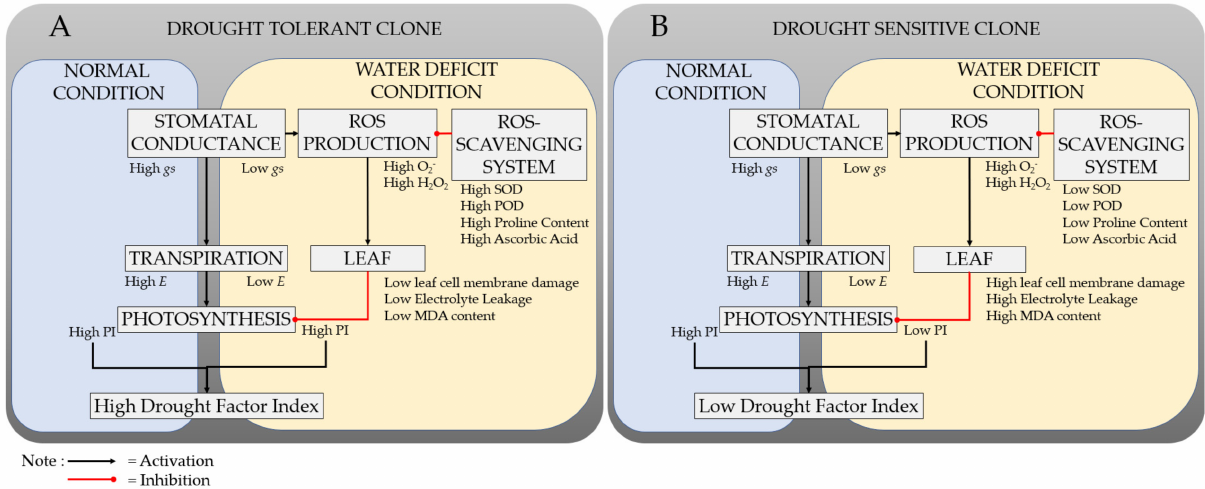
Figure 4. Response mechanisms of drought-tolerant ( A ) and drought-sensitive clone ( B ) to normal and water deficit